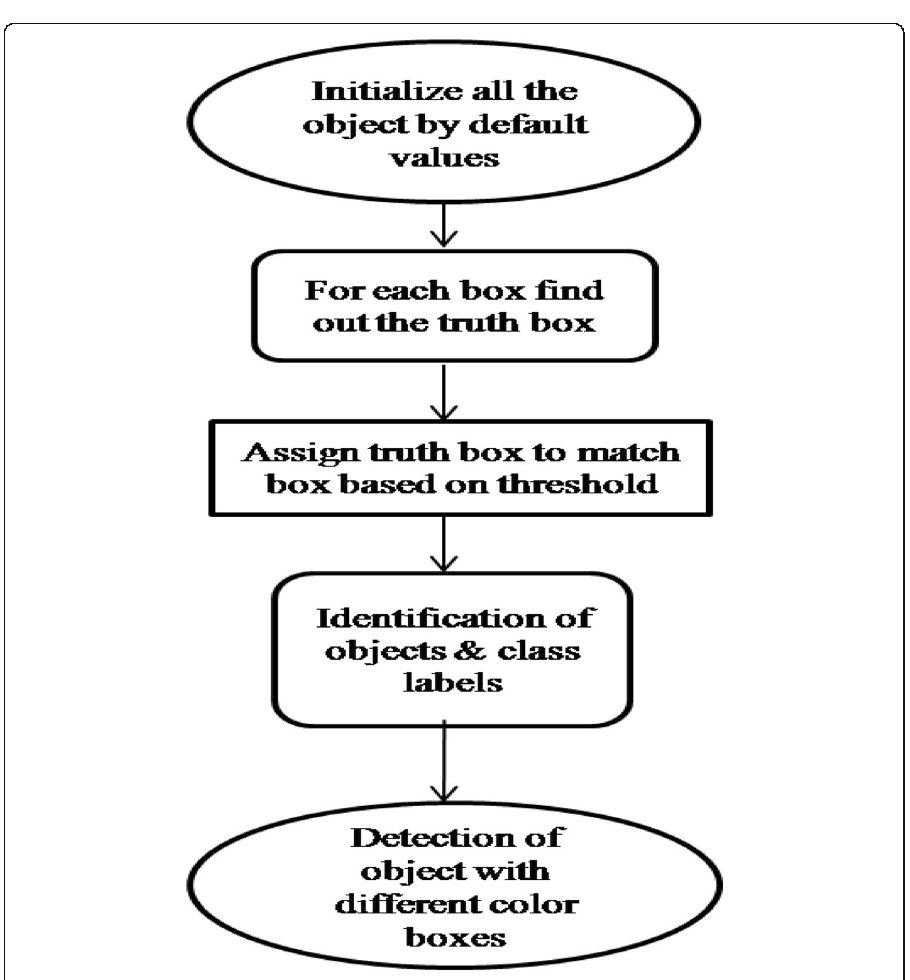
Fig. 5 Process of detecting objects with different color boxes. Demonstrates the process of detecting objects with different color (cid:1) Aspect ratio is used to find out the relationship between the width and height of the image. Basically, it represents a shape of an image. We have used A R to represent the aspect ratio.